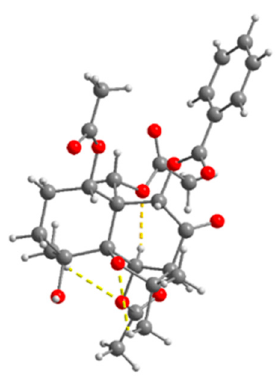
Figure 3. Molecular structure of MD-6. Hydrogen bonds are shown as yellow dashed lines.